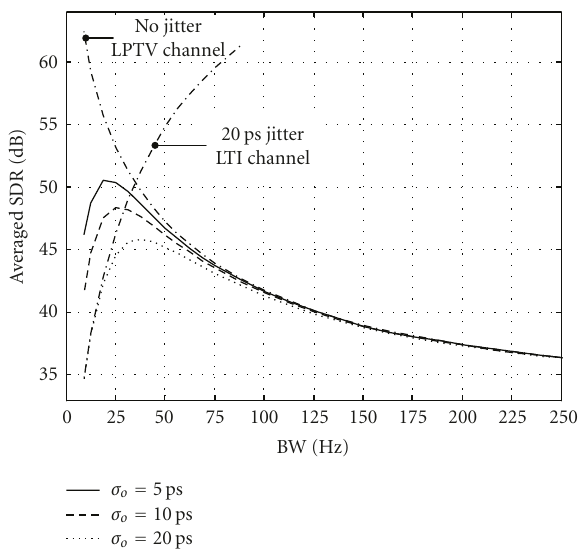
Figure 8: SDR in the last used carrier in di ff erent situations.